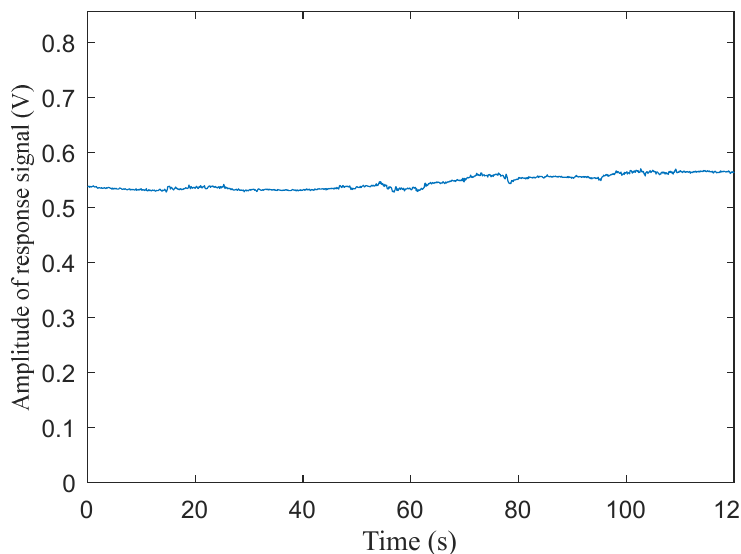
Figure 6. The amplitude of the response signal caused by active light after being separated from the photocell response signal and, secondly, amplified.